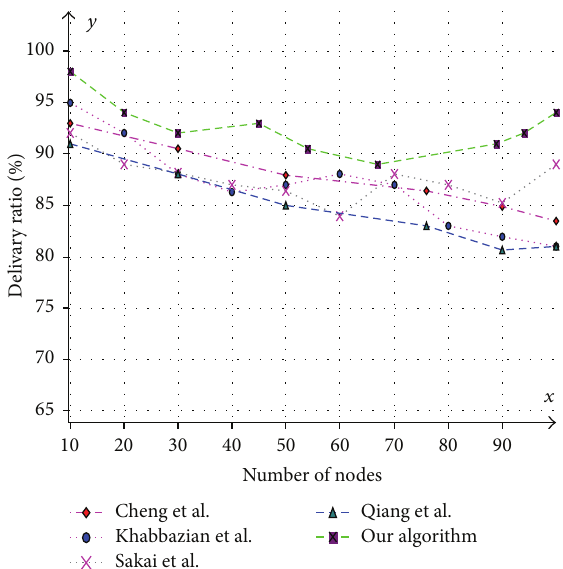
Figure 11: Number of nodes versus CDS size (transmission range = 50 mts and speed = 10mts/s).